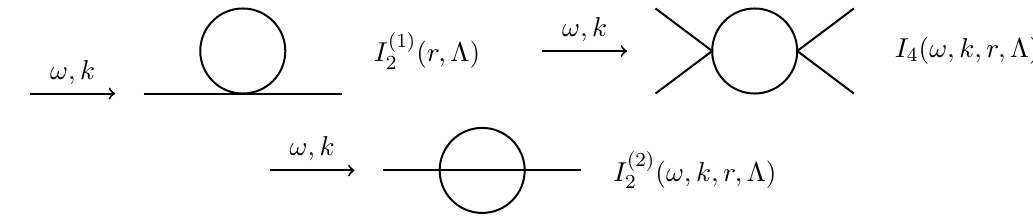
Figure 2. Loop corrections to two- and four-point functions. Total momentum ( !; k ) (cid:13)ows into each diagram from the